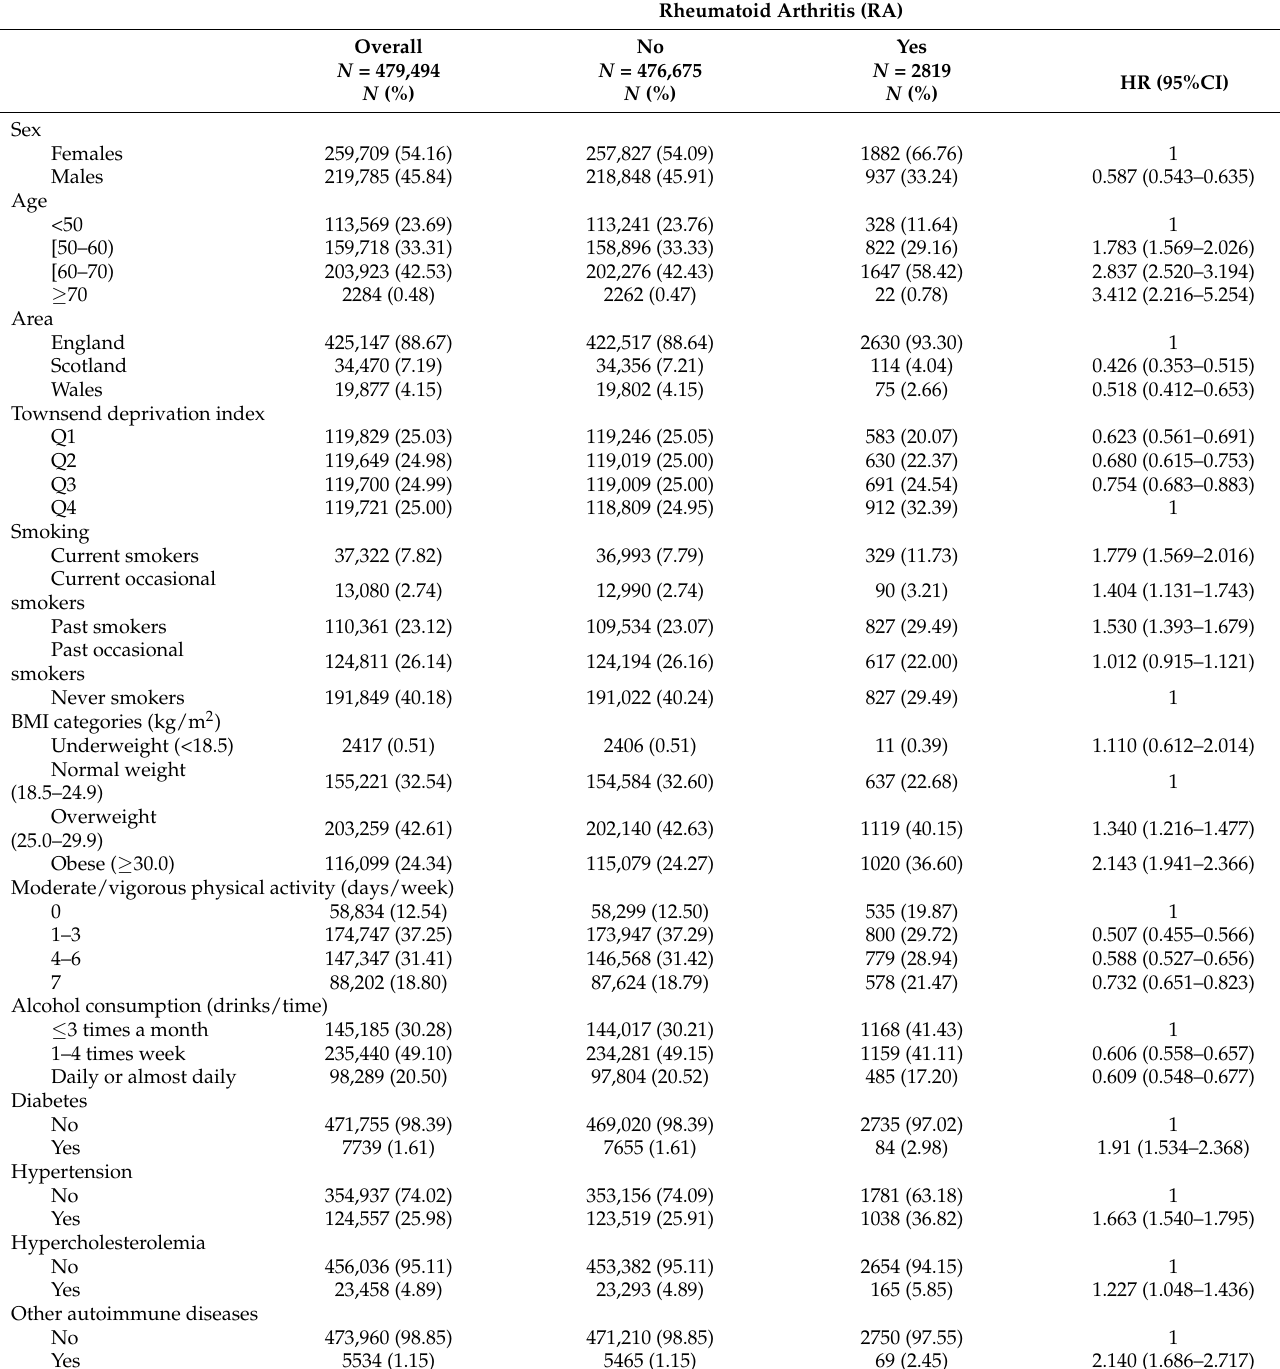
Table 1. Distribution of the main characteristics of the cohort members, hazard ratios (HR) and corresponding 95% confidence intervals (CI) for the association with rheumatoid arthritis